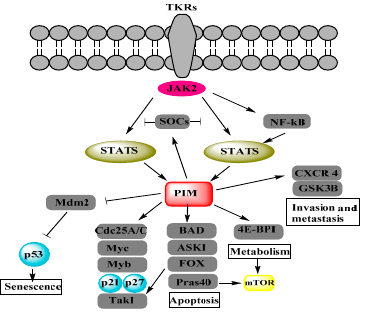
Figure 1. Proviral-integration site for Moloney-murine leukemia virus ( PIM) kinases regulate different cancerous pathways by the phosphorylation of target proteins. Adapted from Figure 2 of [7]. Janus kinase (JAK), nuclear factor of kappa light chain gene enhancer in B cells (NF- κ B), suppressor of cytokine signaling (SOCS), signal transducer and activator of transcription (STAT), BCL2 antagonist of cell death (BAD), cell division cycle 25 (Cdc25), eukaryotic translation initiation factor 4E-binding protein 1 (4E-BP1), mammalian target of rapamycin (mTOR), apoptosis signal- regulating kinase (ASK1), glycogen synthase kinase-3 beta (GSK3 β ), avian myelocytomatosis viral oncogene homolog (Myc), forkhead box (FOX), proline-rich AKT substrate (Pras40), transforming growth factor-beta-activated kinase 1 (Tak1), murine double minutes 2 (Mdm2).